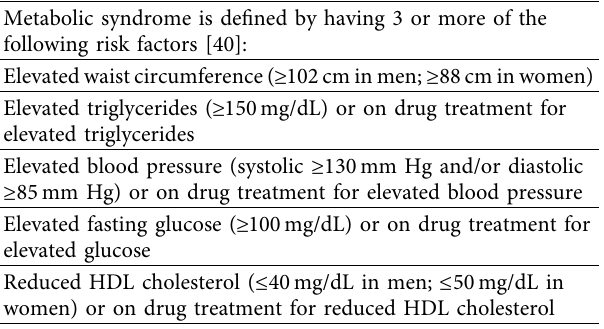
Table 1: Diagnostic criteria for metabolic syndrome. Metabolic syndrome is defned by having 3 or more of the following risk factors [40]: Elevated waist circumference ( ≥ 102cm in men; ≥ 88cm in women) Elevated triglycerides ( ≥ 150mg/dL) or on drug treatment for elevated triglycerides Elevated blood pressure (systolic ≥ 130mm Hg and/or diastolic ≥ 85mm Hg) or on drug treatment for elevated blood pressure Elevated fasting glucose ( ≥ 100mg/dL) or on drug treatment for elevated glucose Reduced HDL cholesterol ( ≤ 40 mg/dL in men; ≤ 50mg/dL in women) or on drug treatment for reduced HDL